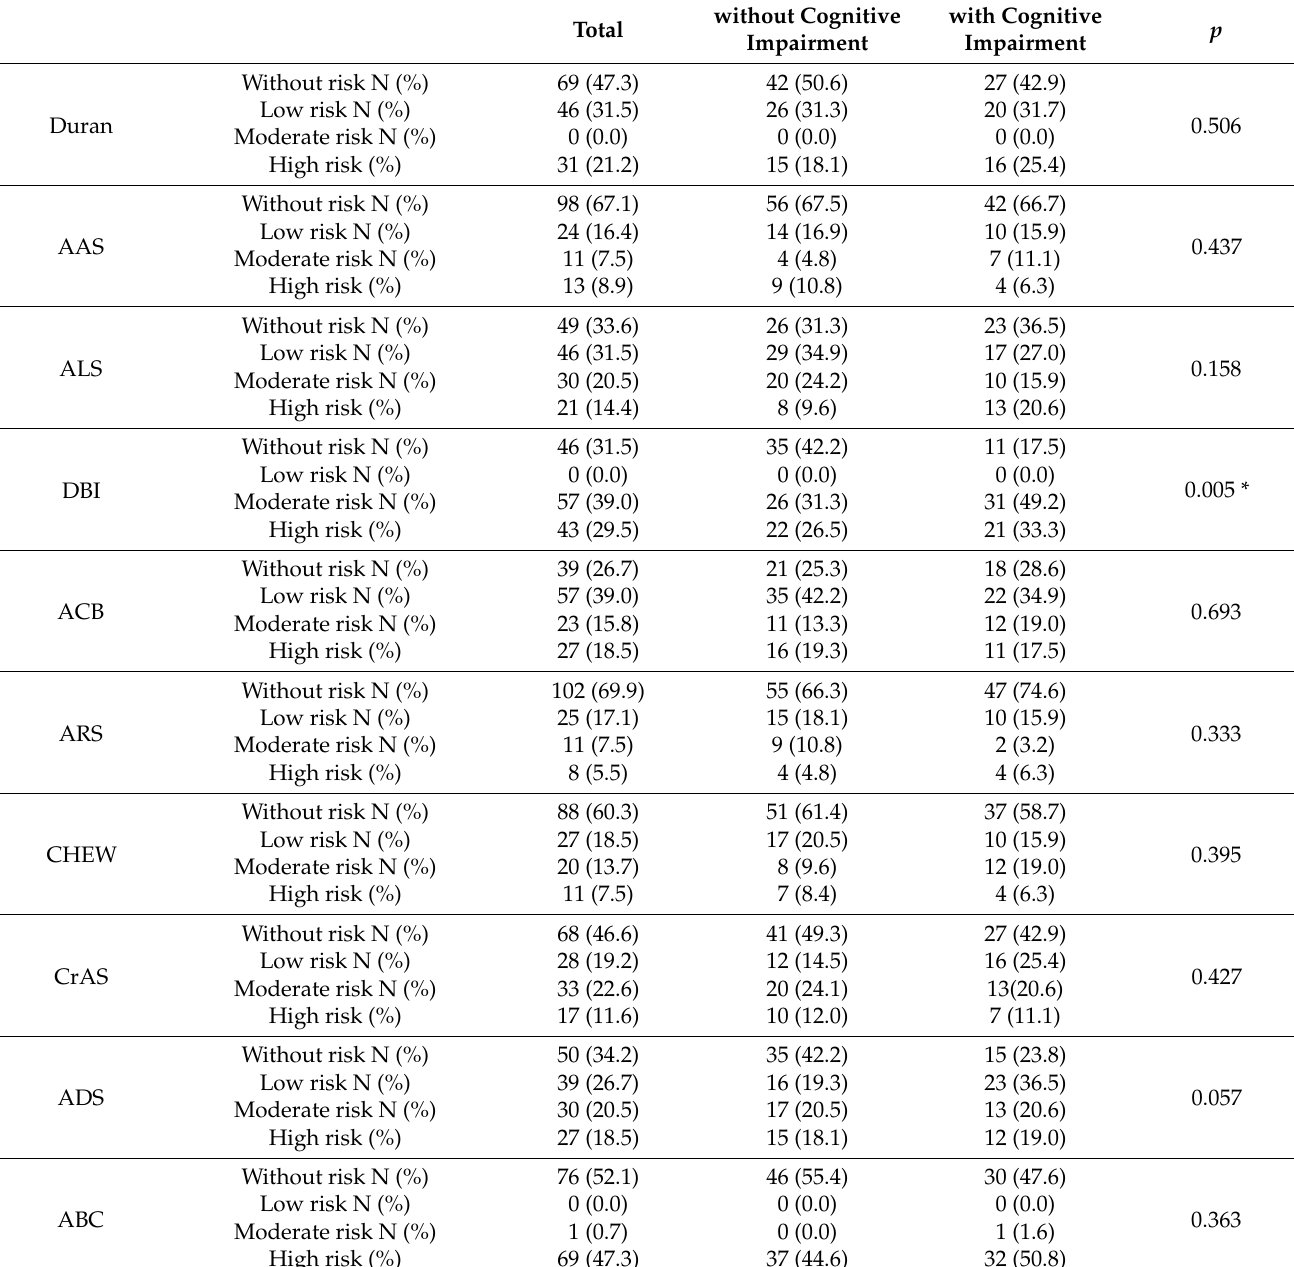
Table A10. Anticholinergic risk by all the scales in subgroups of patients evaluated 12–15 months, with and without cognitive